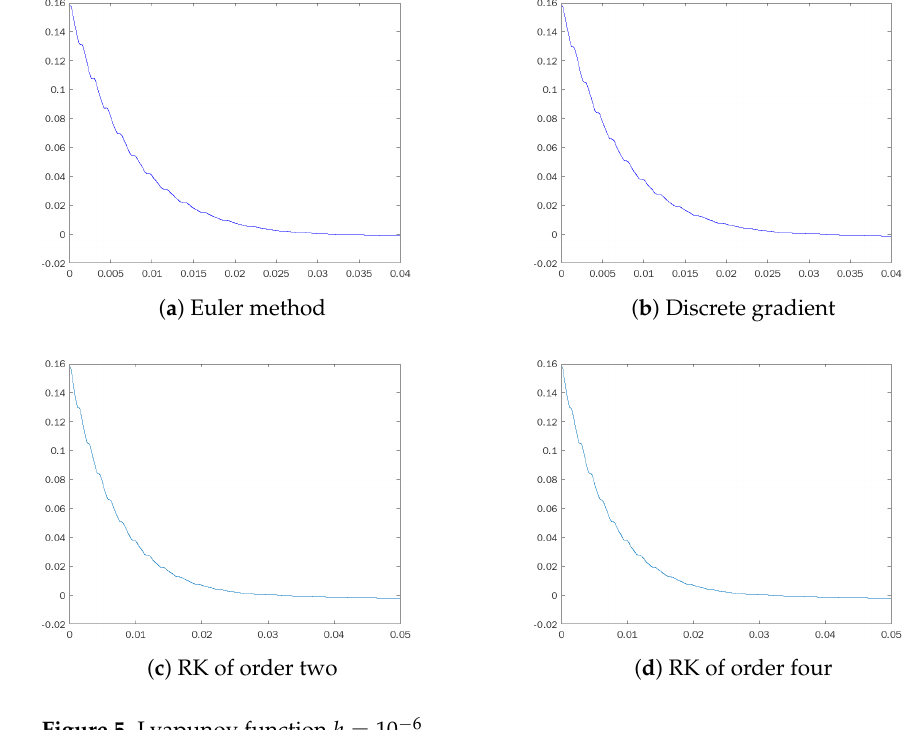
Figure 5. Lyapunov function h = 10 − 6